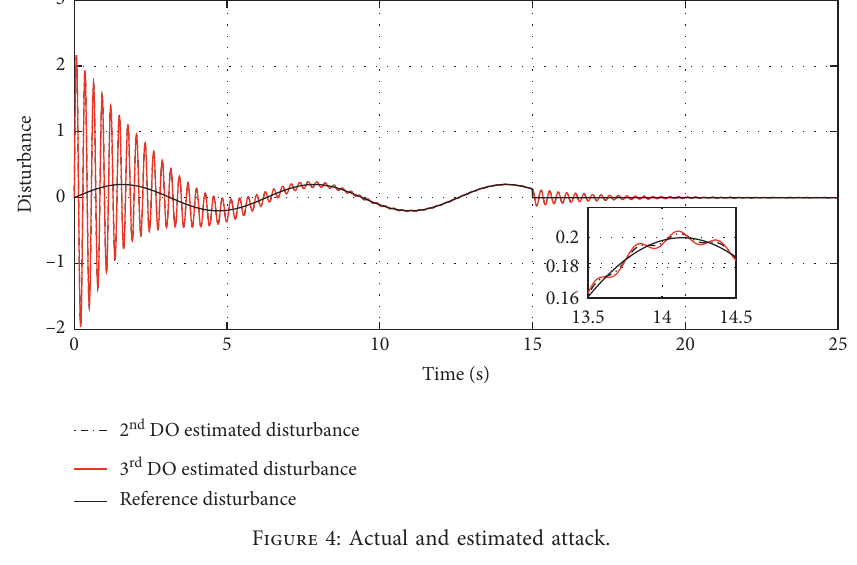
Figure 4: Actual and estimated